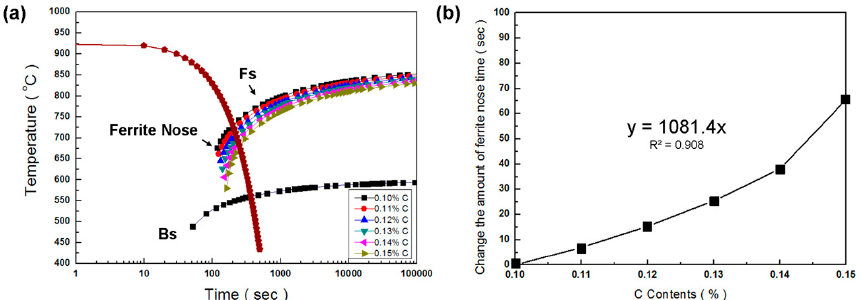
Figure 3. The effect of C addition (0.1–0.15%) on the ferrite continuous cooling transformation (CCT) curve of the model A alloy using material data from JMatPro software: ( a ) CCT curves with varied C additions; ( b ) change in the amount of ferrite nose time for varied C additions.